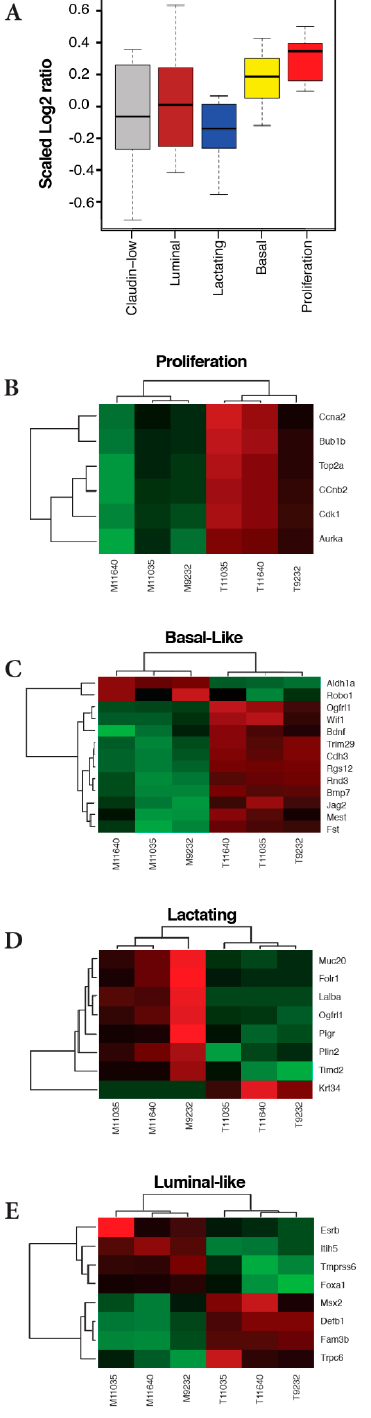
Figure 3. Comparison of BK5-ATF3 tumor data based on the expression of five intrinsic gene sets used to characterize murine models of breast cancer [22]. ( A ) Boxplot of expression log2ratio values for each mouse gene subtype signature (proliferation, basal-like, lactating, luminal, and claudin-low). The log2ratio values were from RNA-Seq and scaled so that the sum of squares in each subtype is 1.0. Only the proliferation and basal gene sets had average log2 ratios significantly different than zero ( p < 0.05). ( B – E ) Heatmaps depicting four of the five gene sets. ( B ) Proliferation. ( C ) Basal-like. ( D ) Lactating. ( E ) Luminal-like. For the boxplots, all the genes of each subtype were used. For the heatmap, the significantly differential genes of each subtype in RNA-Seq were